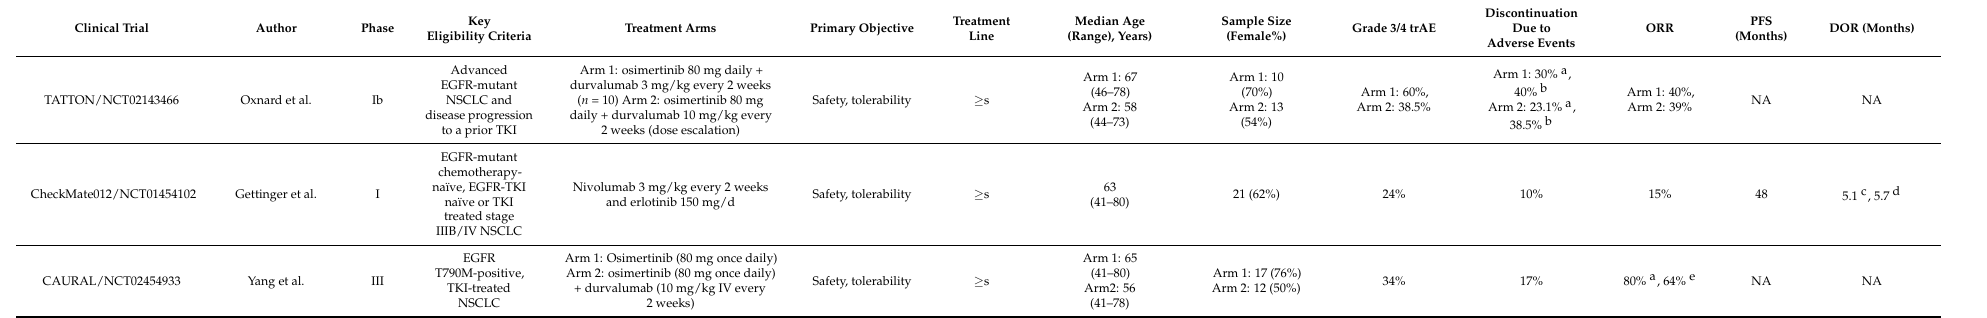
Table 1. Summary of results from included clinical trials of epidermal growth receptor tyrosine kinase inhibitors in combination with immune checkpoint inhibitors.